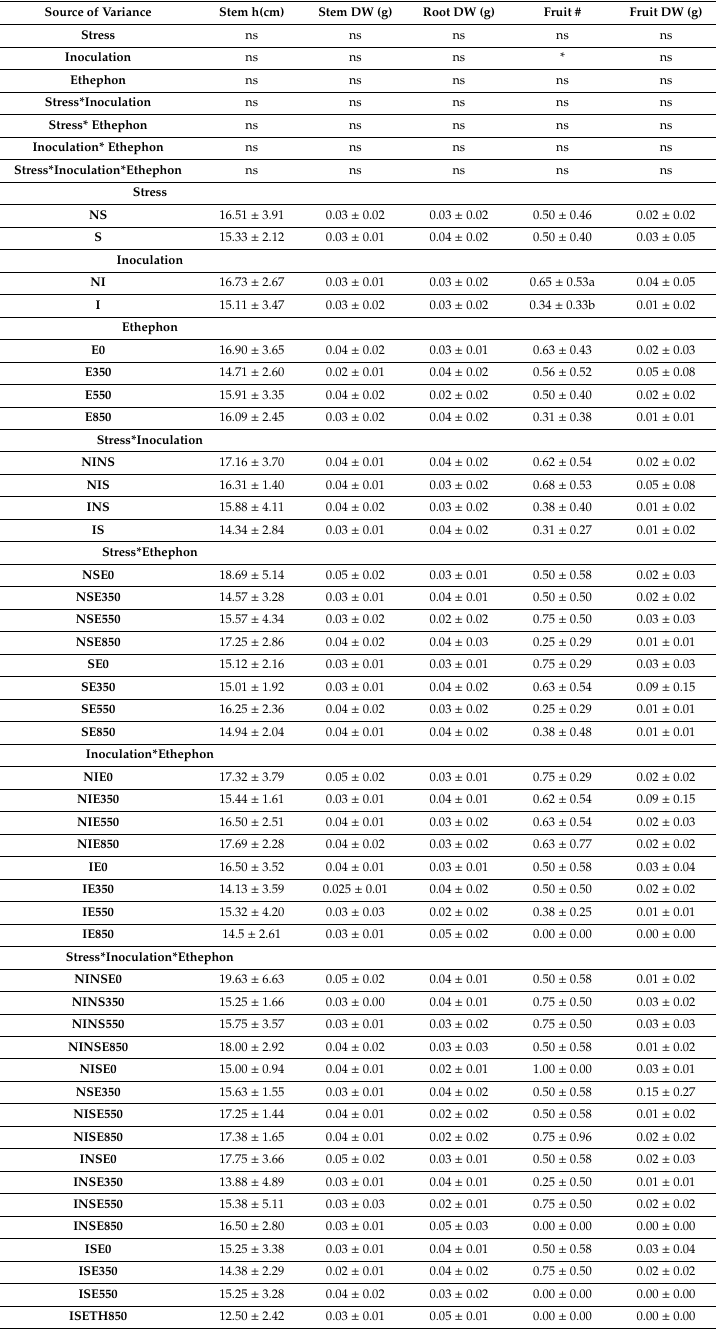
Table 1. Results of morphometric measurements. Average and standard deviation ( ± ) values of four plants for treatment / condition are reported (with the exception of root dry weight from inoculated plants, n = 3). Results of three-way ANOVA for the three considered e ff ects are also included (stress, inoculation and ethephon application). NS, no stress; S, water stress; NI, no inoculation; I, inoculation; E0, E350, E550, E850, ethephon treatments. Codes for p -value: *** 0 ≤ 0.001, ** 0.001 ≤ 0.01, * 0.01 ≤ 0.05, ns not significant. Di ff erent letters within each column indicate significant di ff erences according to Tukey HSD test ( P ≤ 0.05). DW: dry weight, h: